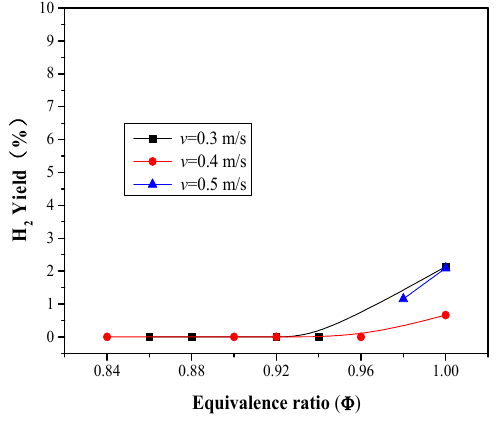
Figure 11. Product yield of H 2.